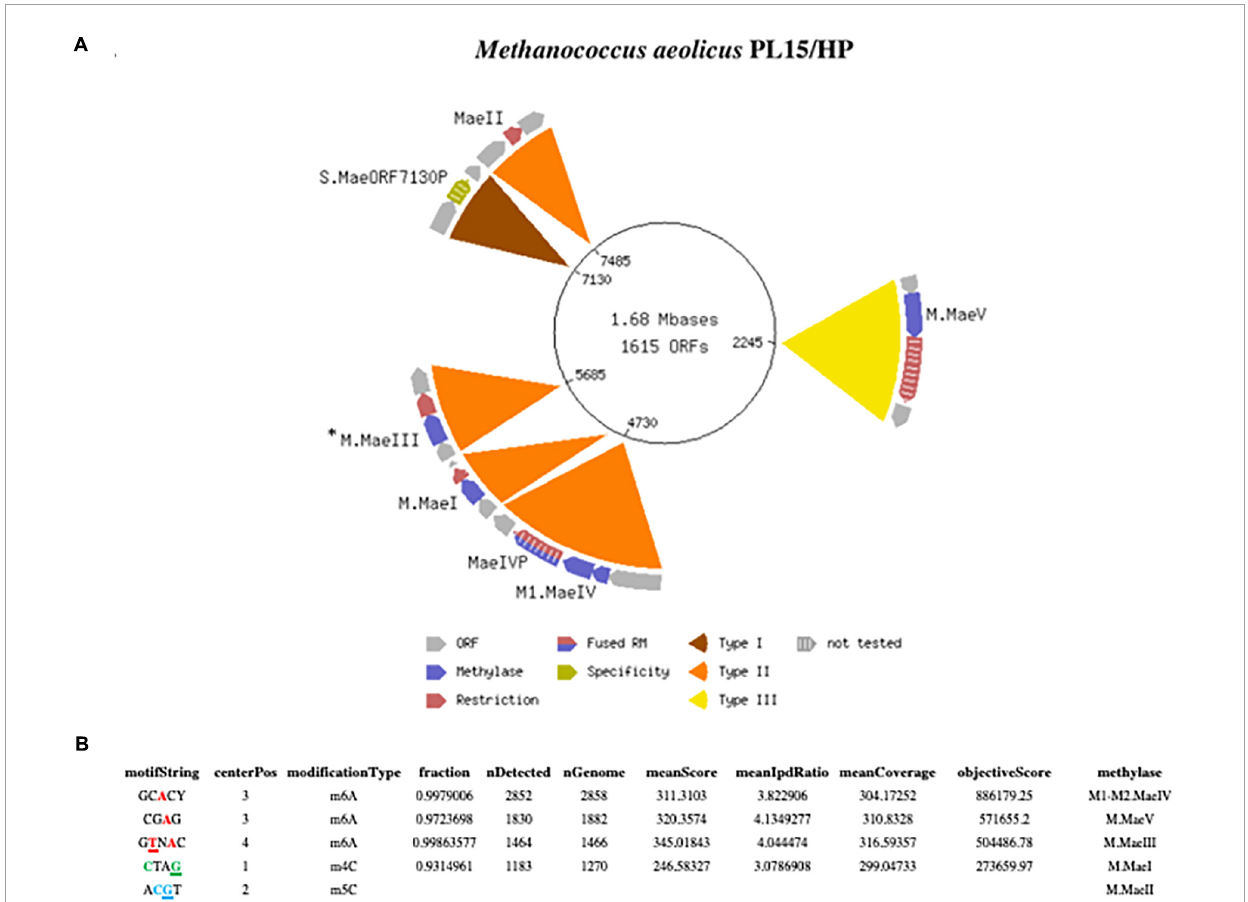
FIGURE1 (A) Schematic presentation of the complete closed circular genome of Methanococcus aeolicus PL15/H p showing the location of the RM systems. The M. Mae III gene was not directly identified by the Seqware program (*). (B) Detection of modified DNA motifs identified by SMRT sequencing in M. aeolicus PL15/H p genome. Note that 5mC methylation by the M. Mae II gene was not directly identified by SMRT